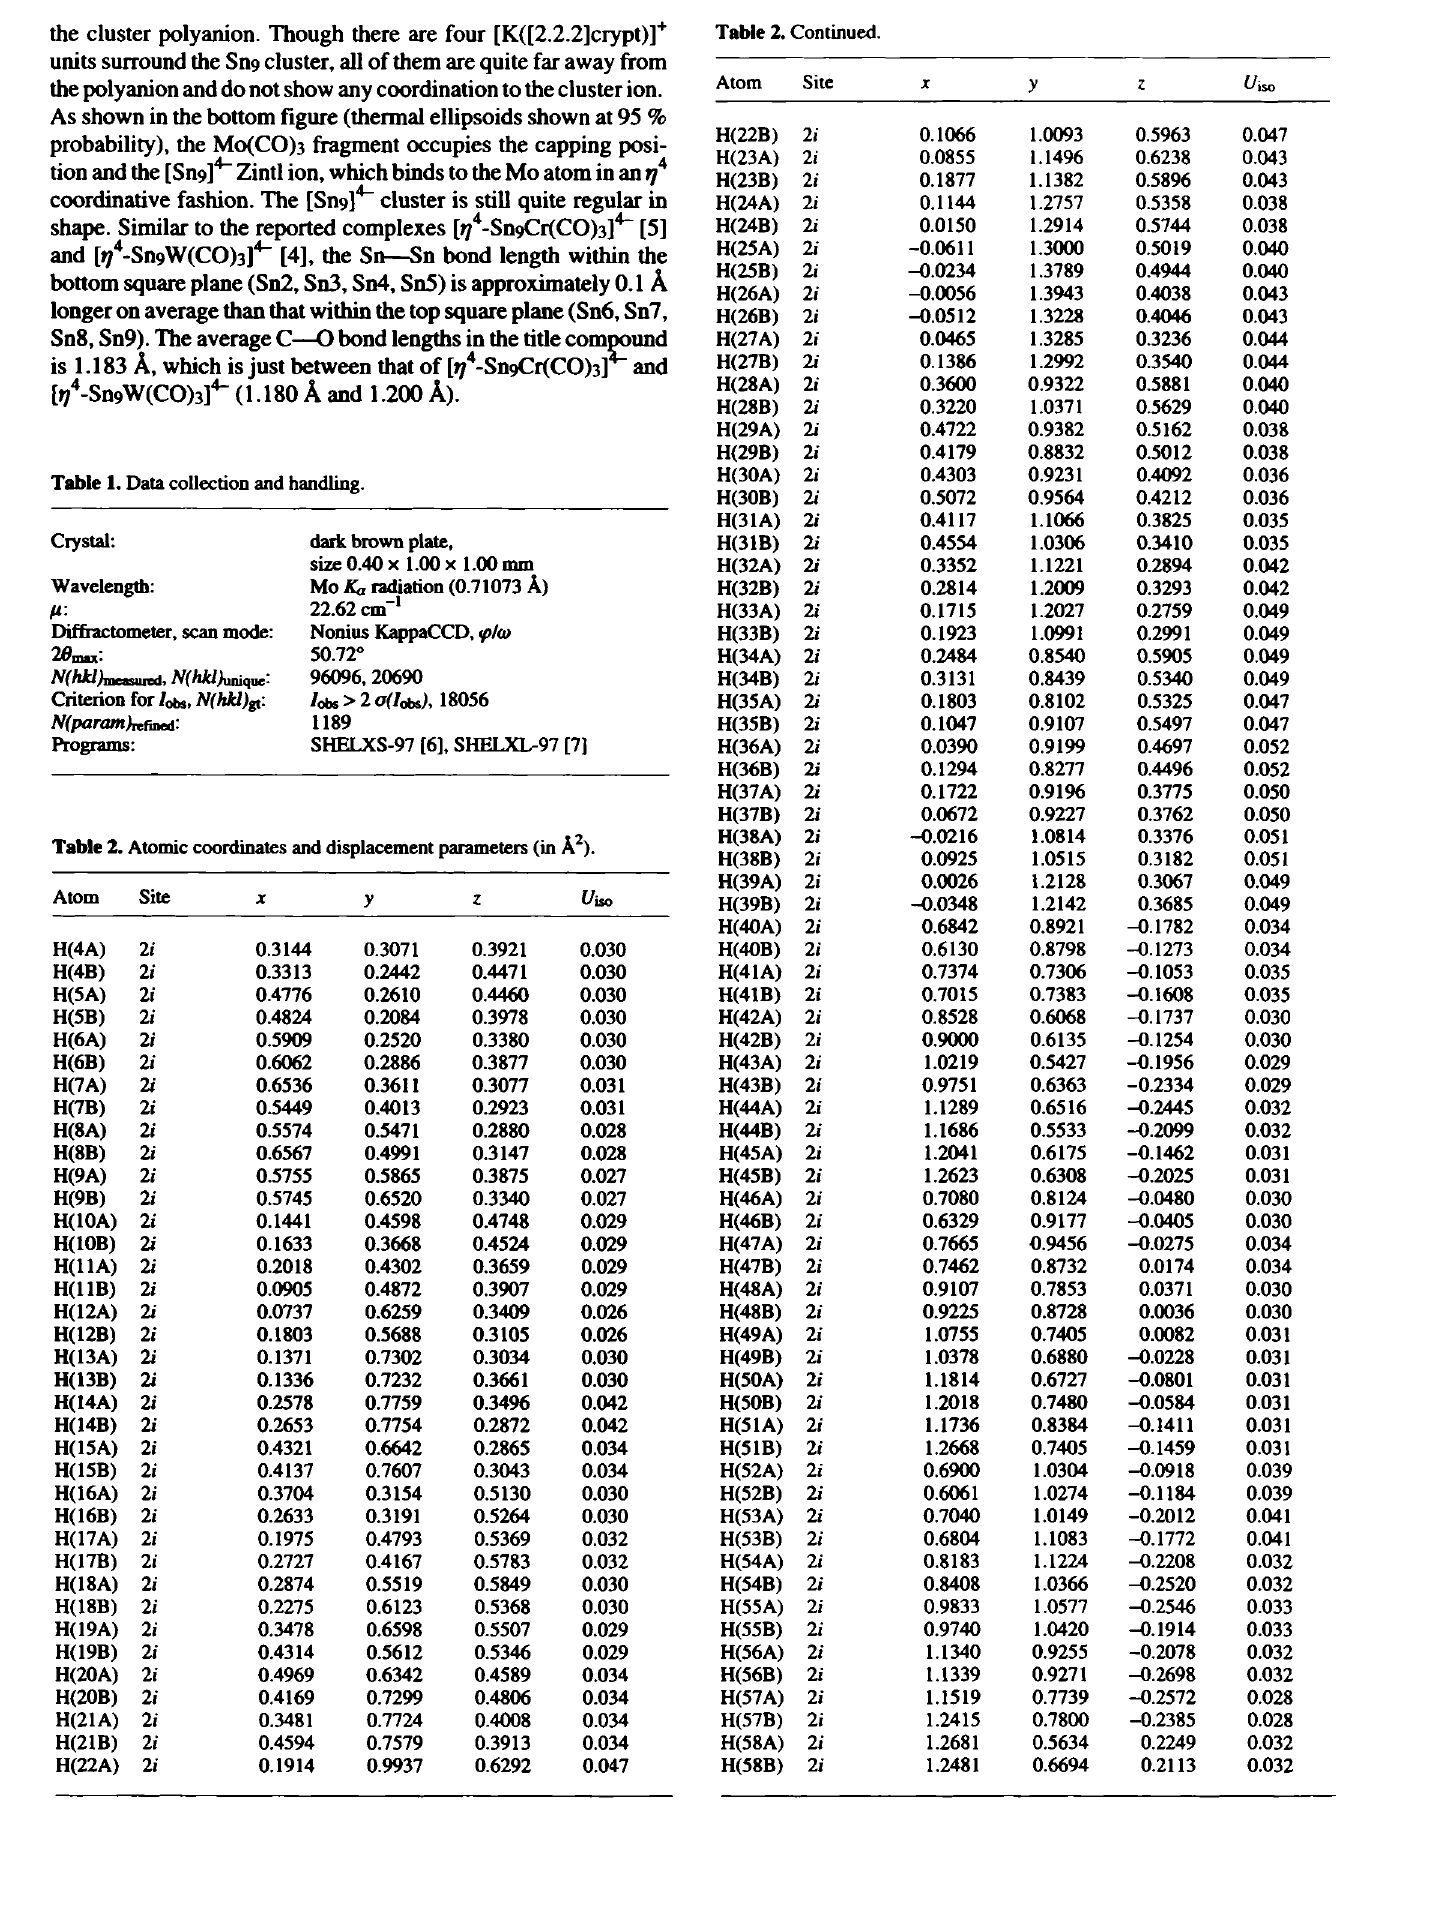
Table 2. Atomic coordinates and displacement parameters (in A 2